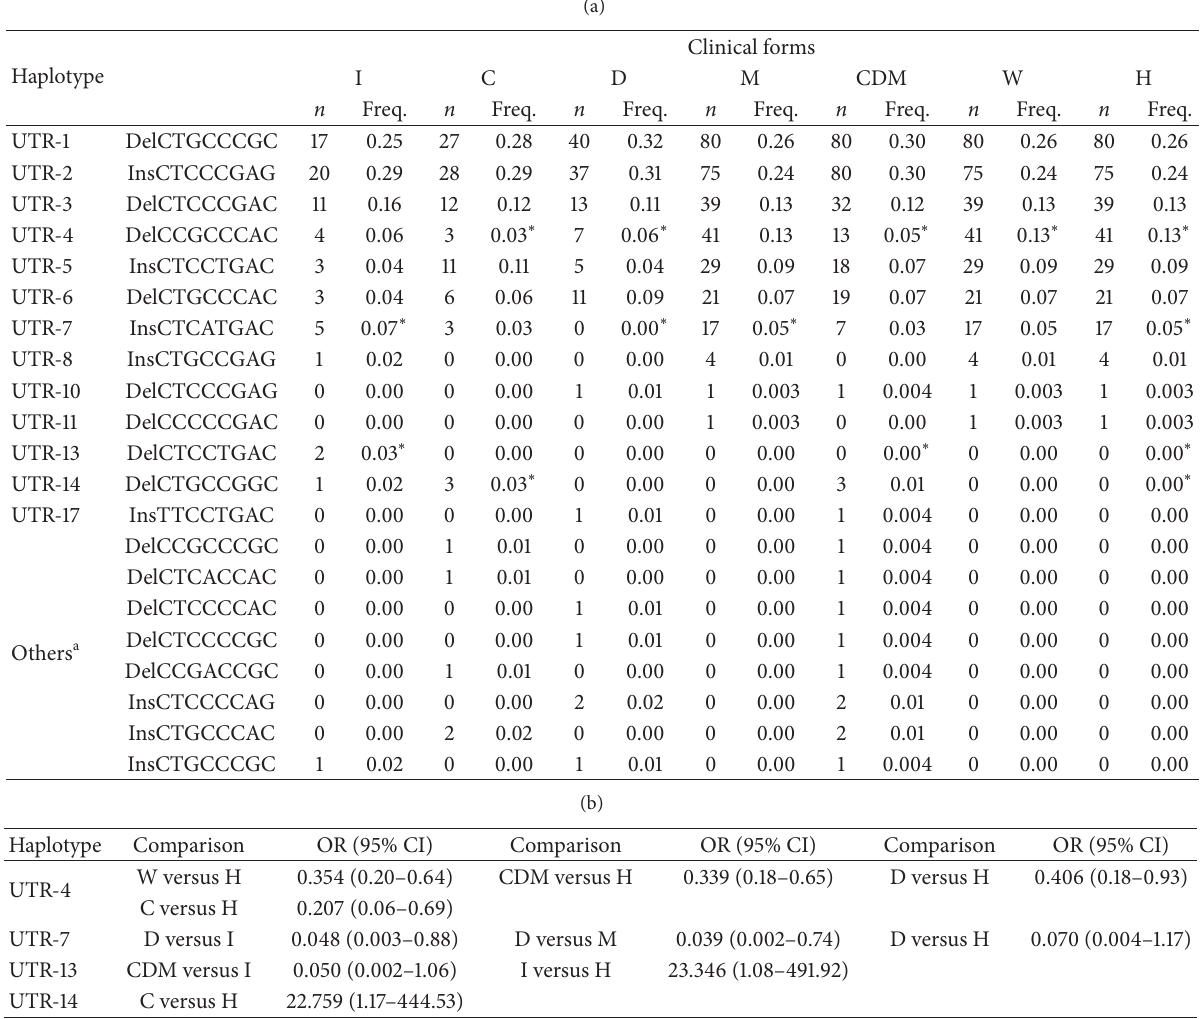
Table 3: (a) Haplotype frequencies in patients with Chagas disease stratified according to clinical forms and healthy controls and (b) Odds Ratioand95%ConfidenceIntervalvaluesobtainedfromthecomparisonsofhaplotypesfrequenciesofvariationsitesat HLA-G 3 󸀠 untranslated region (3 󸀠 UTR) between different presentation forms of Chagas disease and healthy